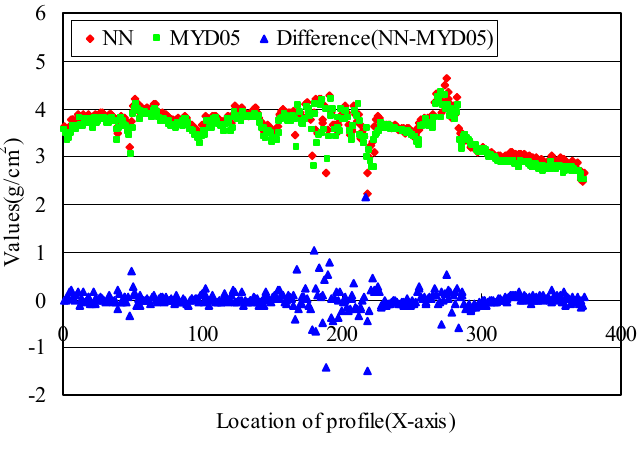
Figure 12. The X -axis profile in Figures 9–11.